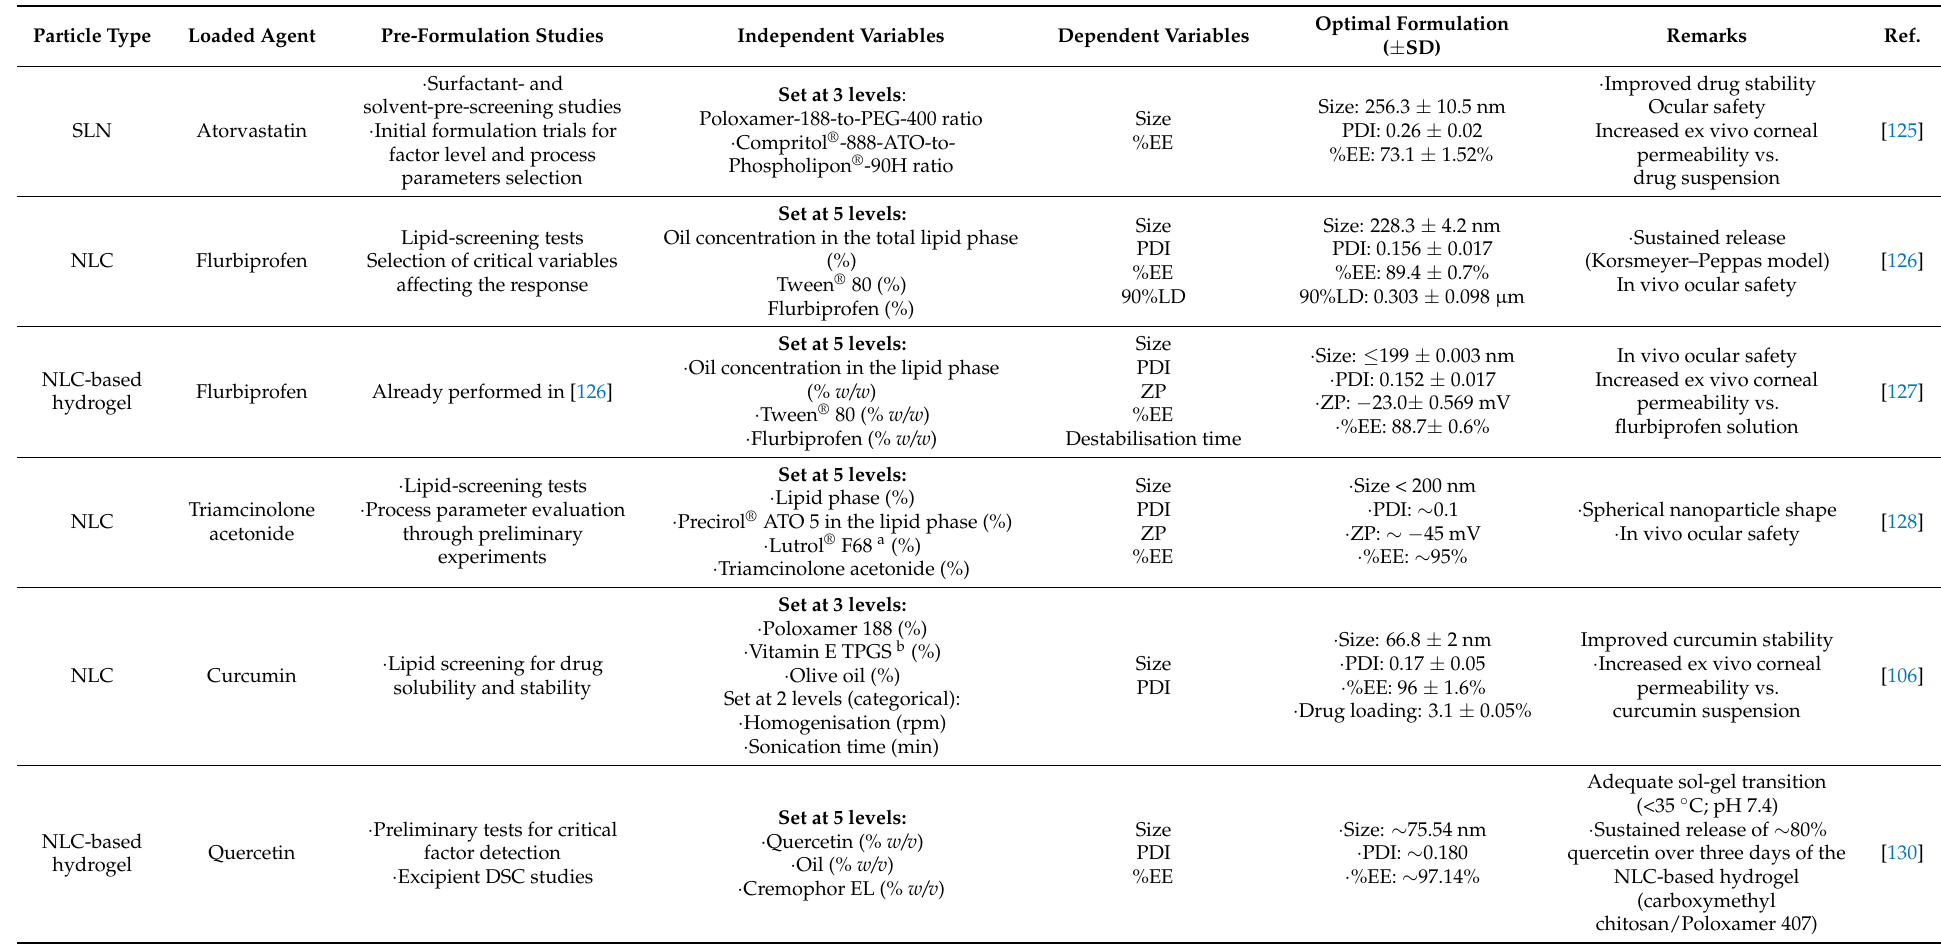
Table 3. Examples of the application of central composite designs in the production and optimisation of lipid-based nanocarriers intended for ocular delivery. Particle